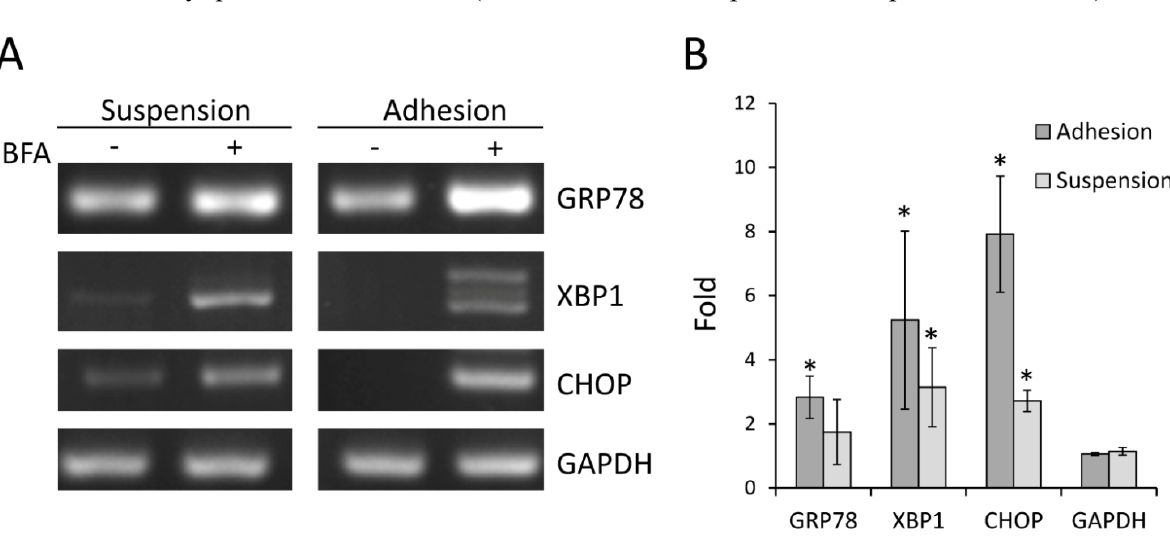
Figure 5. BFA induced the expression of ER stress-related genes in Colo 205